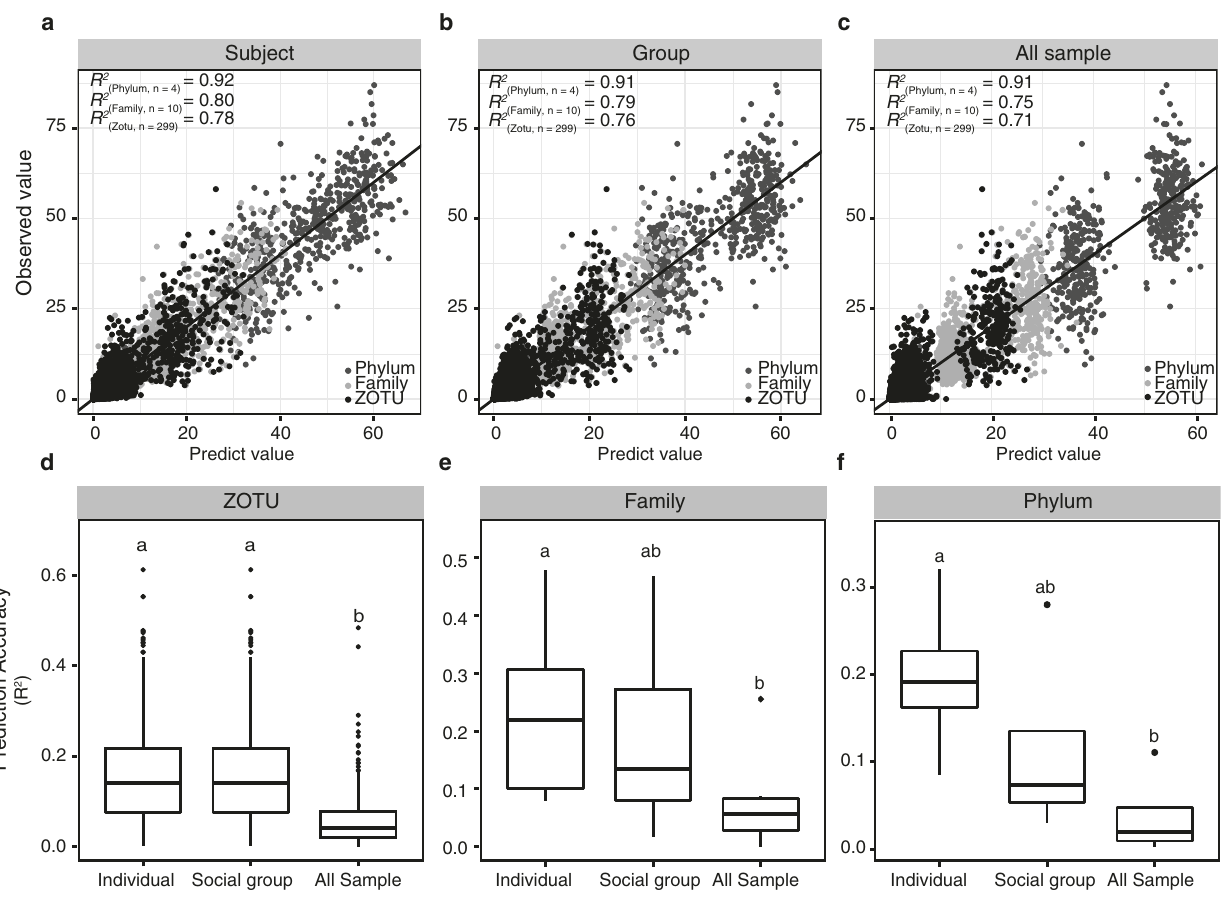
Fig. 8 Prediction performance between different biotic levels in different sampling scales. The comparison of cross-validation results ( a – c ) and prediction accuracies ( d – f ) between different biotic levels in different sampling scales. a – c Scatter plots showing the predicted and observed values of relative abundances of different biotic levels inferred from dietary compositions. Colors represented different biotic levels (dark gray: phylum; light gray: family; black: ZOTU). The diagonal line represented perfect prediction (predicted value = observed value). d – f The accuracy of random forest models in predicting relative abundances in different taxa. Signi fi cant differences among different datasets were denoted by lettering ( P < 0.05, ANOVA followed Duncan ’ s test). The detailed information was summarized in Supplementary Table